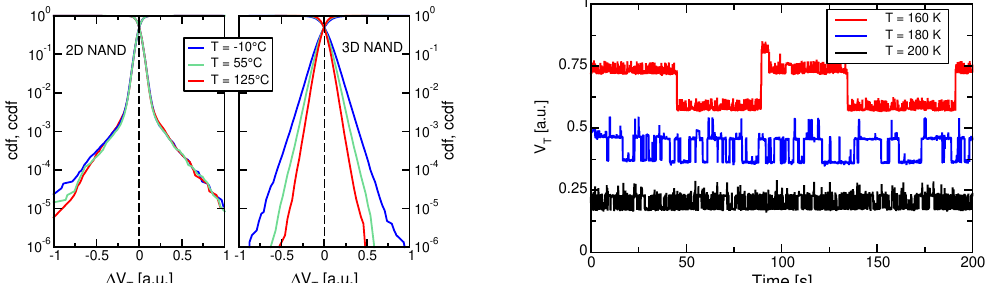
Figure 4. ( Left ) RTN cumulative density function (cdf) and its complementary (ccdf) for 2D and 3D NAND arrays at different temperatures [125,126], © 2017, IEEE. ( Right ) V T fluctuations due to single RTN traps at different